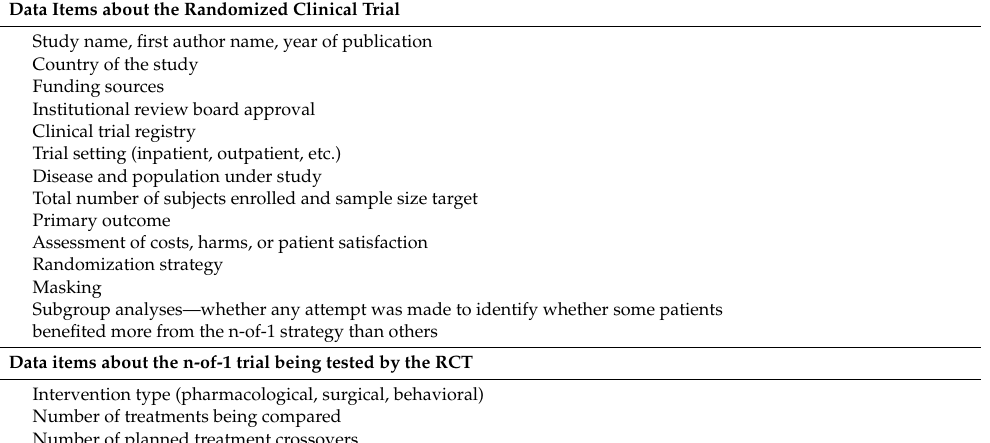
Table 1. Data items to be